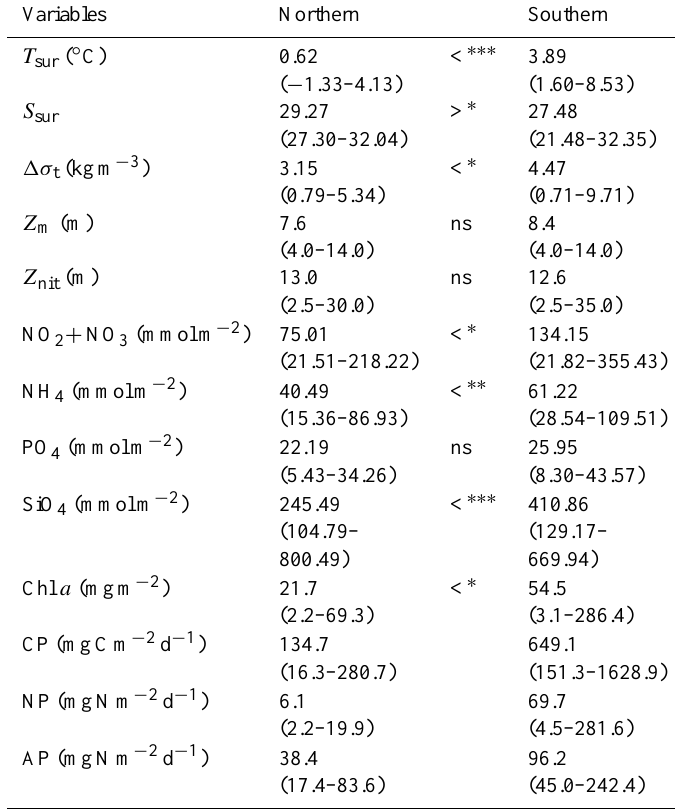
Table 2. Summary of one-way analysis of variance (ANOVA) for environmental variables in two geographic regions of the Chukchi Sea in 2012. The mean values (ranges in parentheses) and their significant differences (>or<) between the northern and southern regions are given for surface temperature ( T sur ), surface salinity ( S sur ), stratification index ( (cid:49)σ t ), surface mixed-layer depth ( Z m ), nitracline depth ( Z nit ), freshwater content (FWC), nitrite + nitrate inventory of the upper 30m (NO 2 + NO 3 ), ammonium inventory of the upper 30m (NH 4 ), phosphate inventory of the upper 30m (PO 4 ), silicate inventory of the upper 30m (SiO 4 ), and chlorophyll a content in the upper